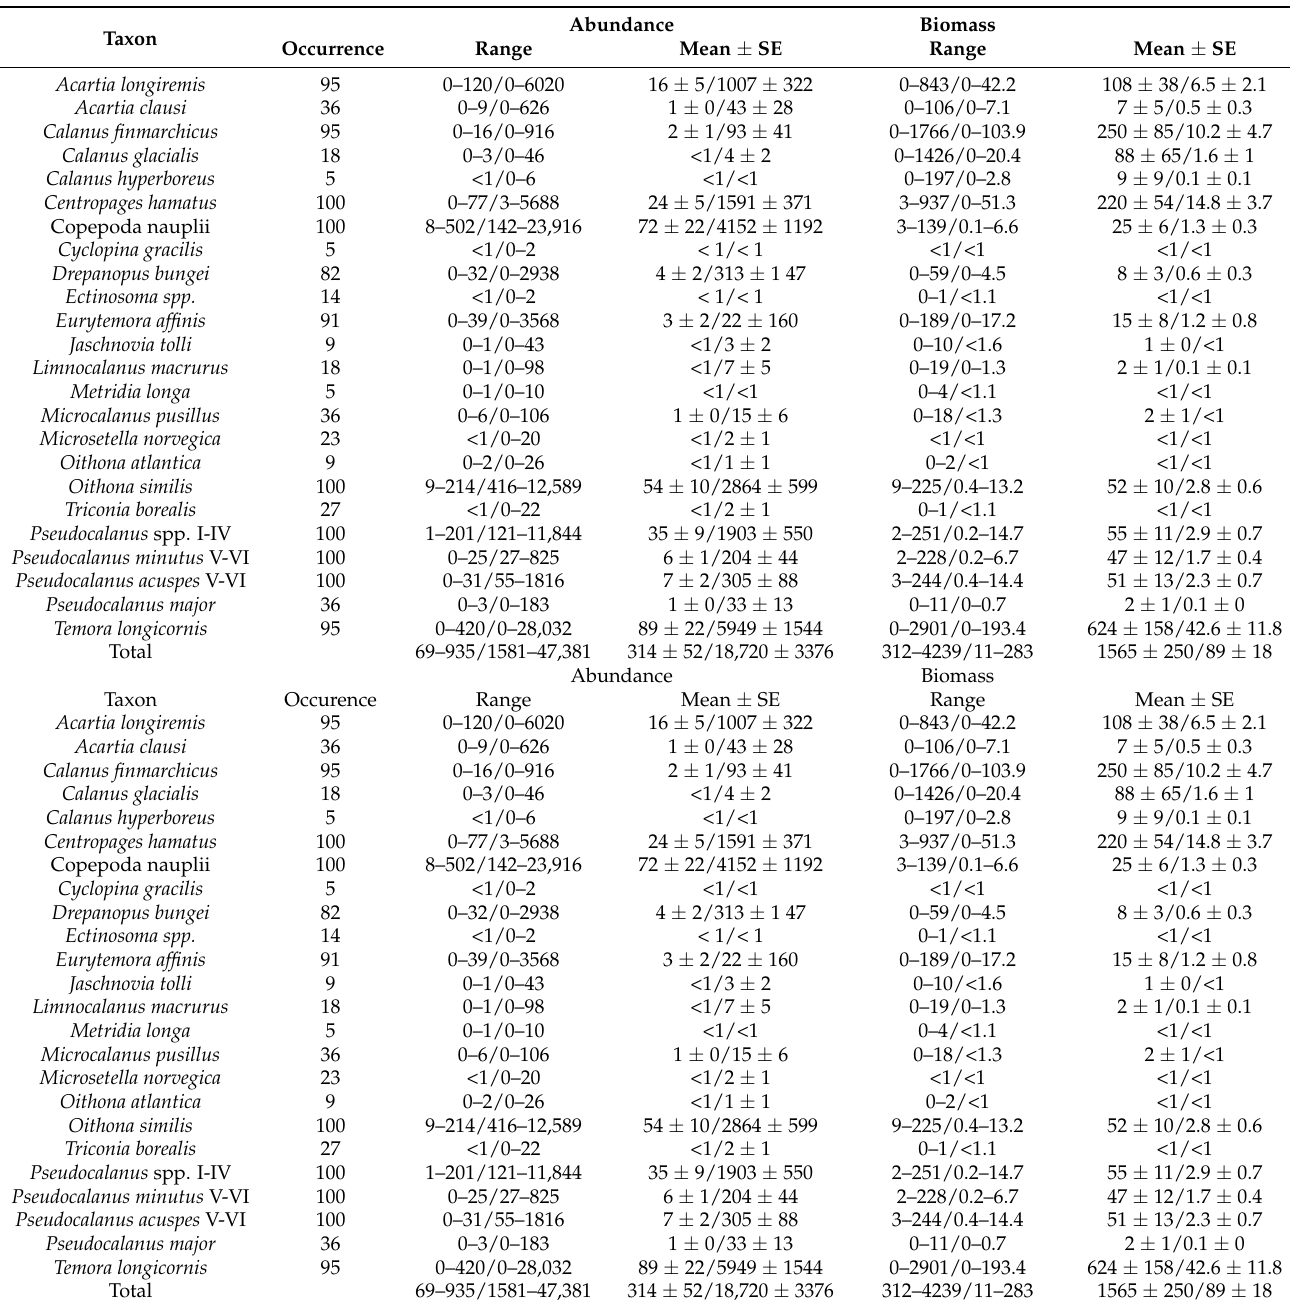
Table 3. Copepod composition, occurrence (%), abundance (10 3 ind. m − 2 /ind. m − 3 ) and